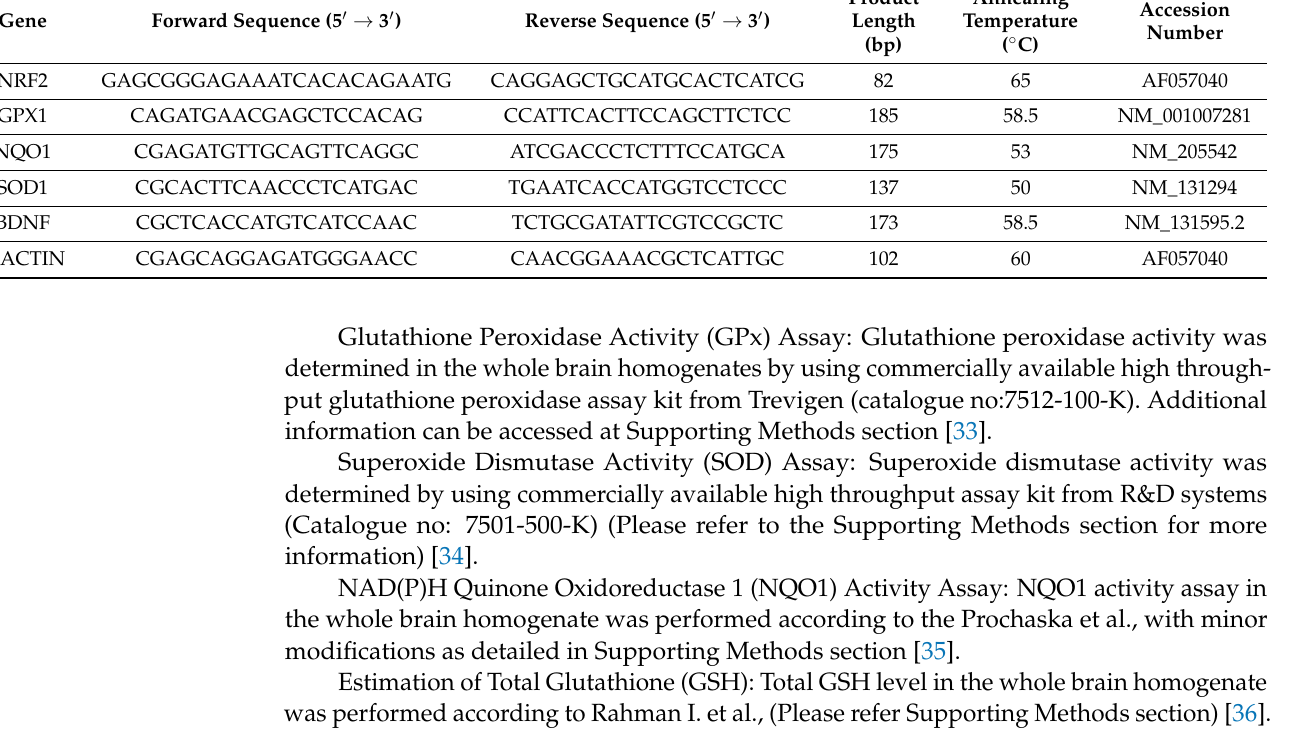
Gene Forward Sequence (5 (cid:48) → 3 (cid:48)